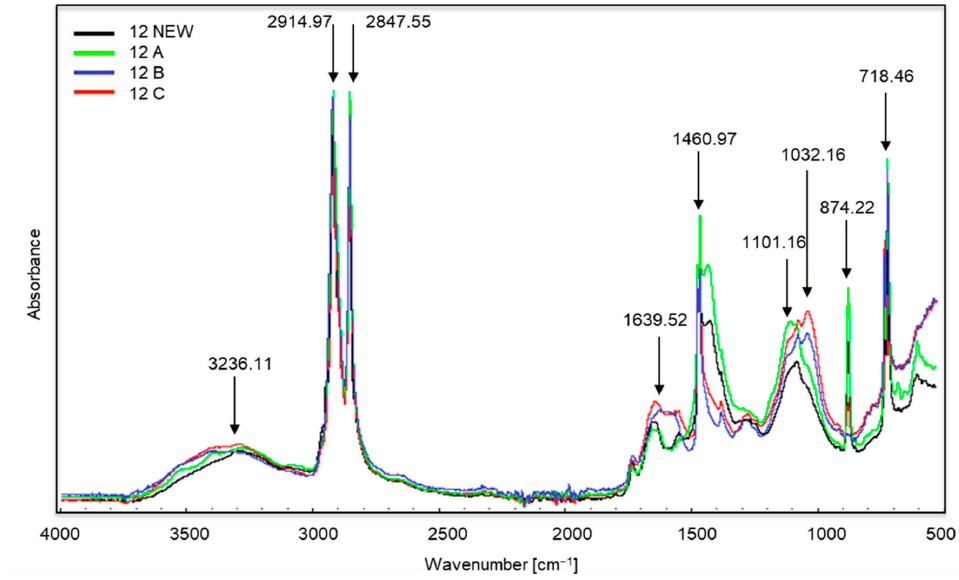
Figure 5. Spectra of sample no. 12 (the entire sample was made up of brown